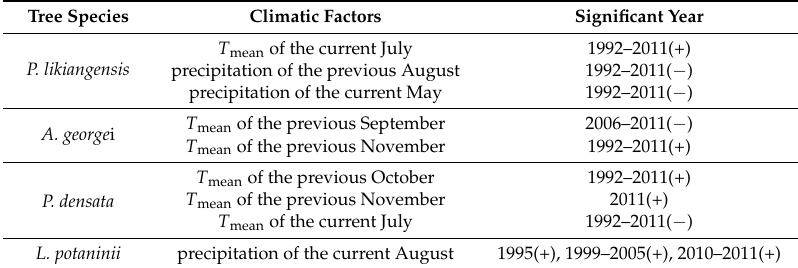
Table 3. Correlation analysis with moving intervals between the residual chronologies and the monthly climatic factors. A 32-year moving window was